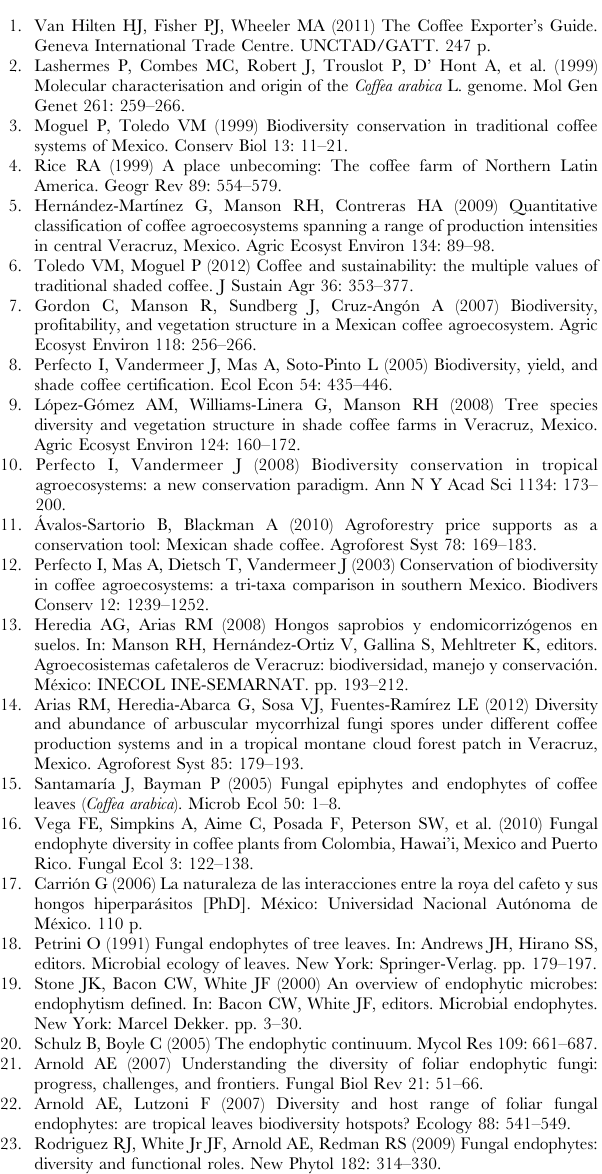
Table S1 Description of morphospecies of foliar endophytic fungi isolated from the four coffee